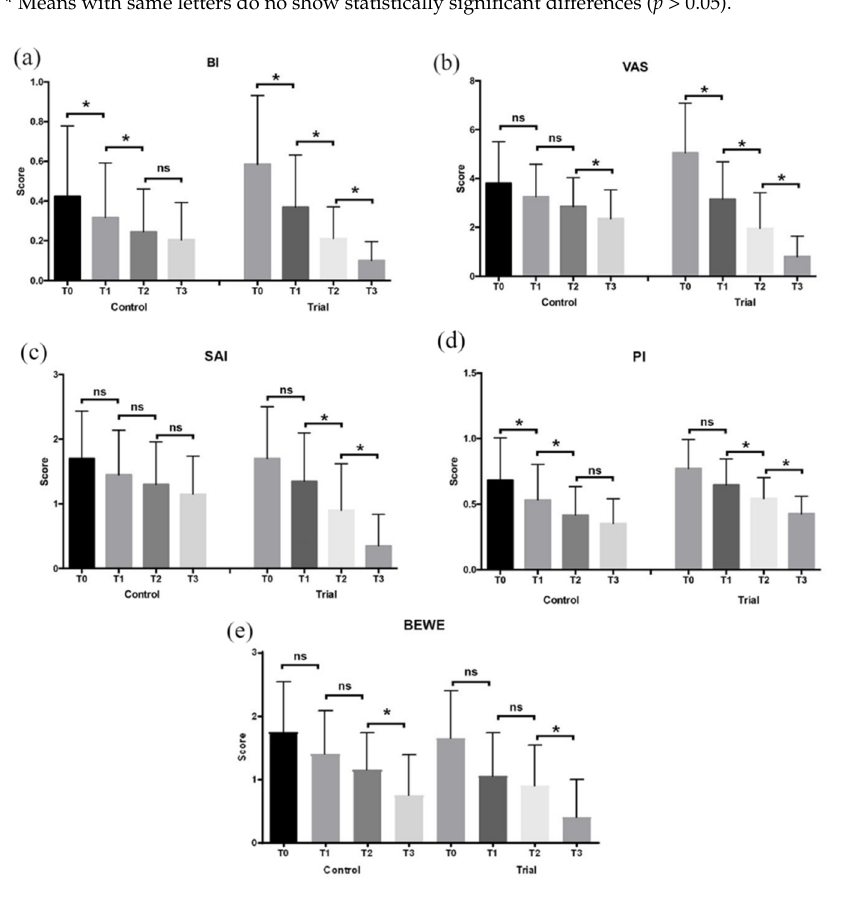
Table 3. Descriptive statistics of SAI measurements.